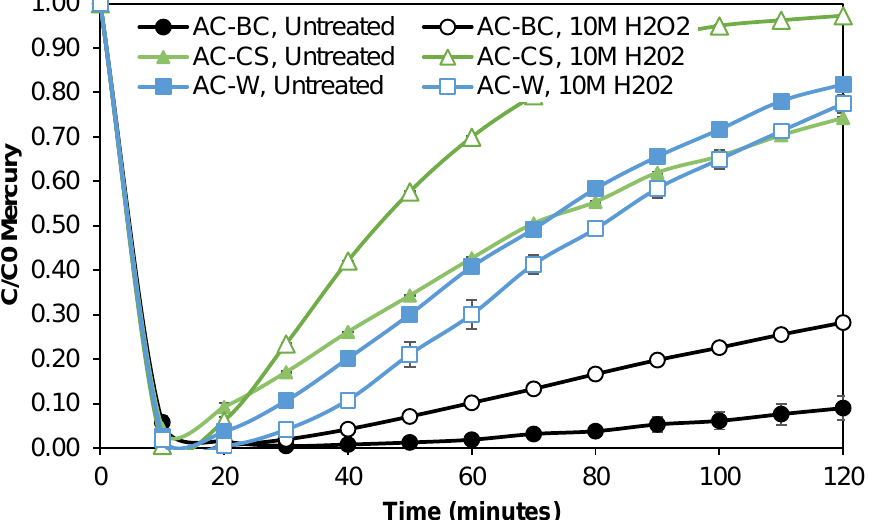
Figure 11. Mercury removal for activated carbons treated with 10 M Hydrogen Peroxide.